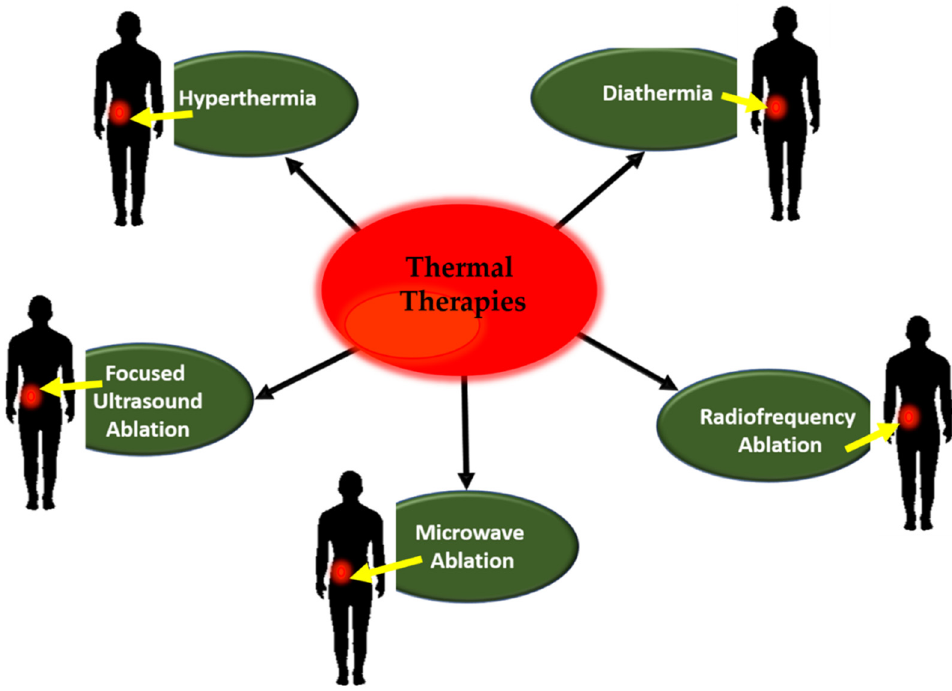
Figure 1. Types of thermal therapies.